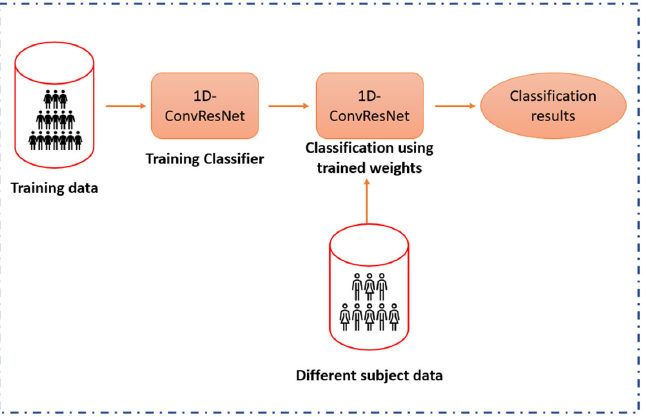
Figure 8. Subject ‐ independent classification using transfer learning. We trained the model using training subjects’ data. Later, we classified test subjects’ data using the trained weights.